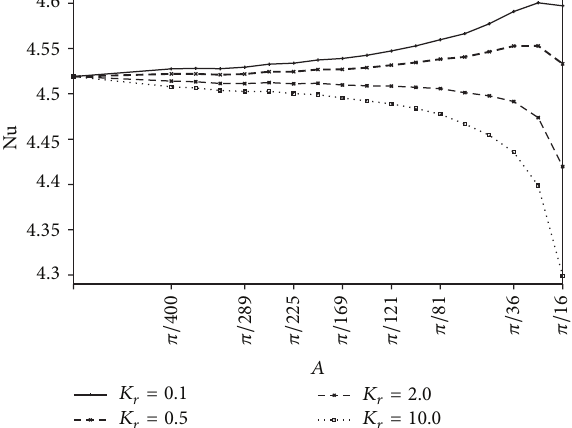
Figure 8: Variation of Nu with 𝑁 for different values of Ra at 𝐾 𝑟 = = 0.5 , and 𝐴 = 𝜋/25 . 1.0 , 𝑋 0